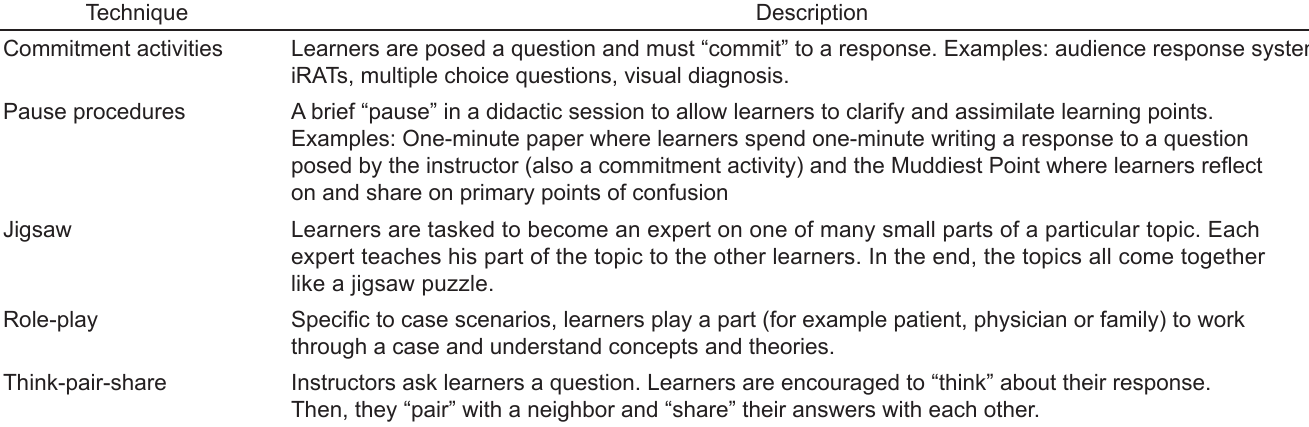
Table. Techniques to engage learners in didactive lectures